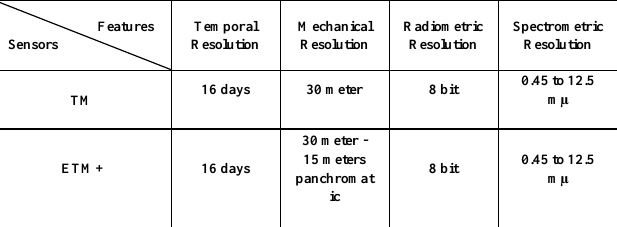
Table 1: Features of the images used in the